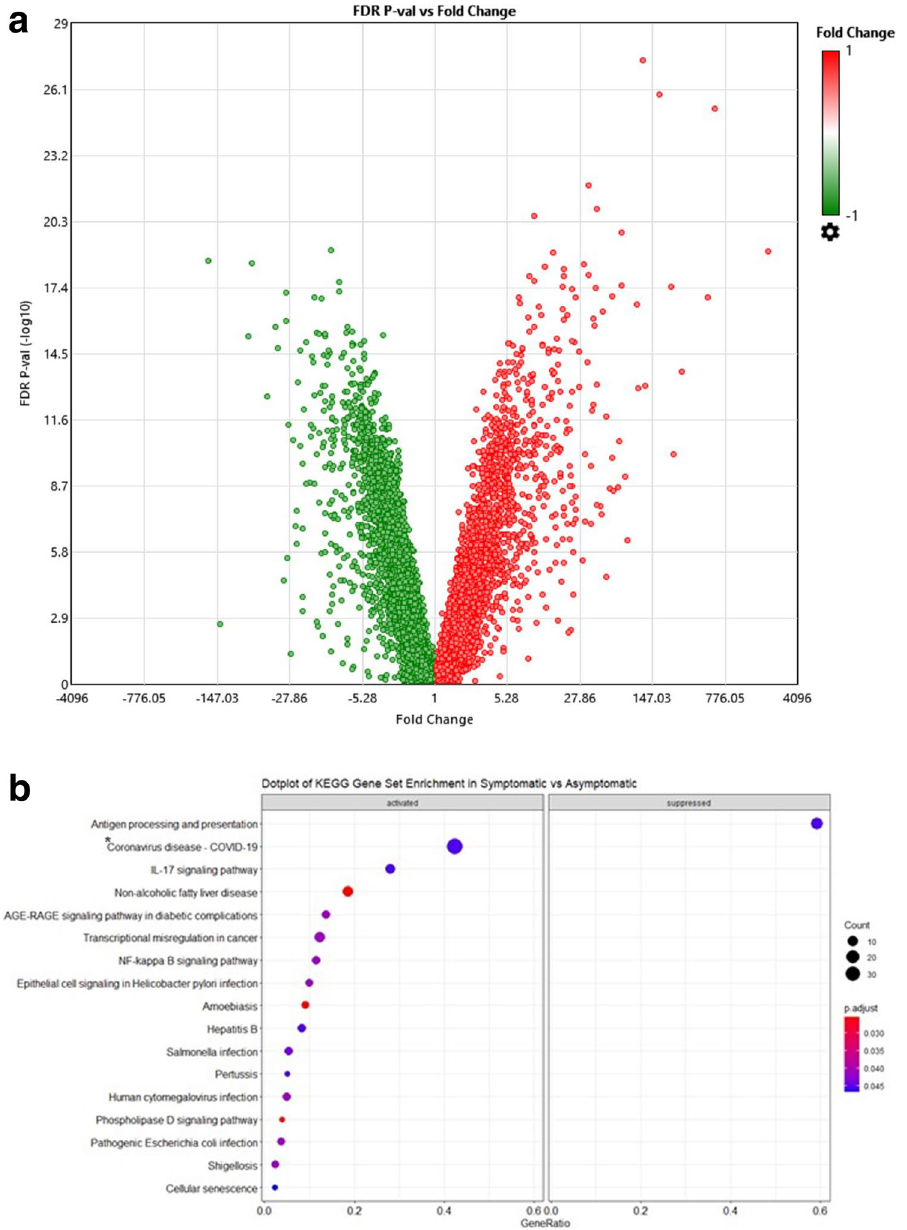
Figure 2. Symptomatic vs Asymptomatic COVID-19. ( a ) Volcano plot of Symptomatic vs Asymptomatic COVID-19 cases. The log2 (FC) (fold change) is plotted on the x-axis, and the negative log10 (FDR) (p-value) is plotted on the y-axis. The red points on the plot show Upregulated expression (n = 1939 genes), Downregulated genes (n = 1465) are shown in green. Analysis with the absolute value of log2 (FC) not less than 1 (FC = 2) and FDR values less than 0.05. ( b ) Dotplot of gene set enrichment analysis on KEGG molecular pathway applied on Symptomatic vs Asymptomatic COVID-19. KEGG molecular pathways on y-axis and gene ratio on x-axis. The greater the size of circle the greater the number of genes involved in a pathway the circles are colored based on p-adjusted value. ‘*’ ‘Coronavirus disease pathways’ ribosomal pathways, CXCL8 and NF-kB